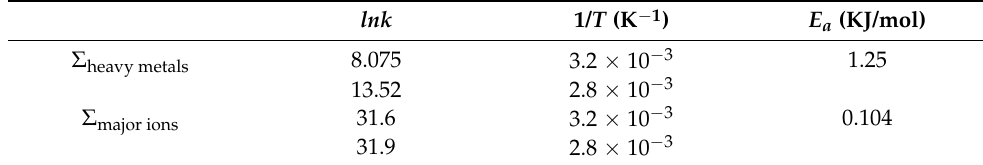
Table 5. Activation energy derived by Arrhenius Equation